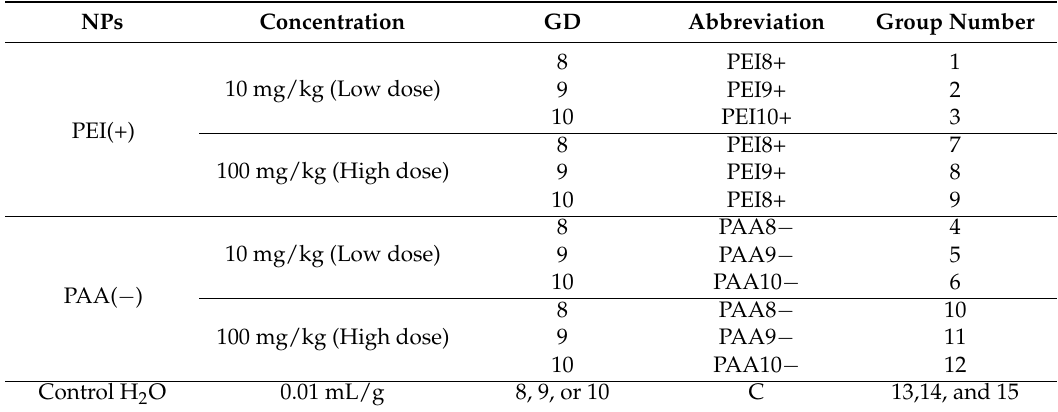
Table 7. Treatment groups received PEI- or PAA-coated iron oxide NPs at 10 or 100 mg/kg body mass or the vehicle control (H 2 O) on GD 8, 9, or